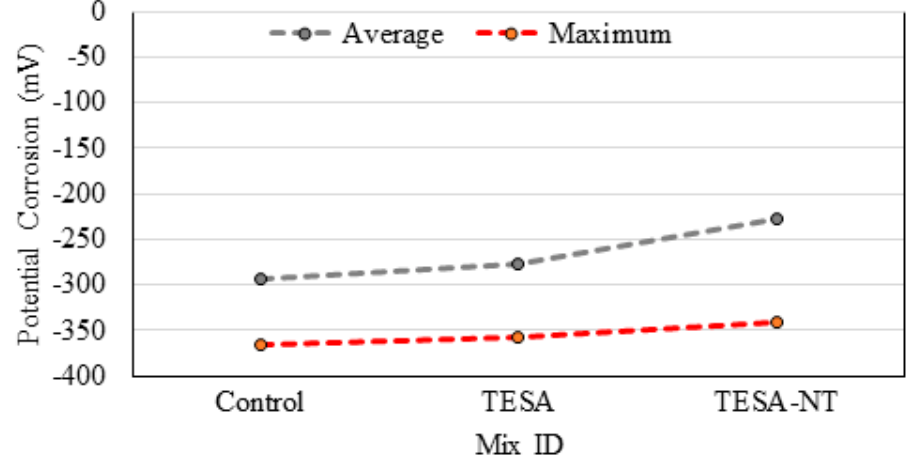
Figure 3. Corrosion potential after accelerated corrosion.